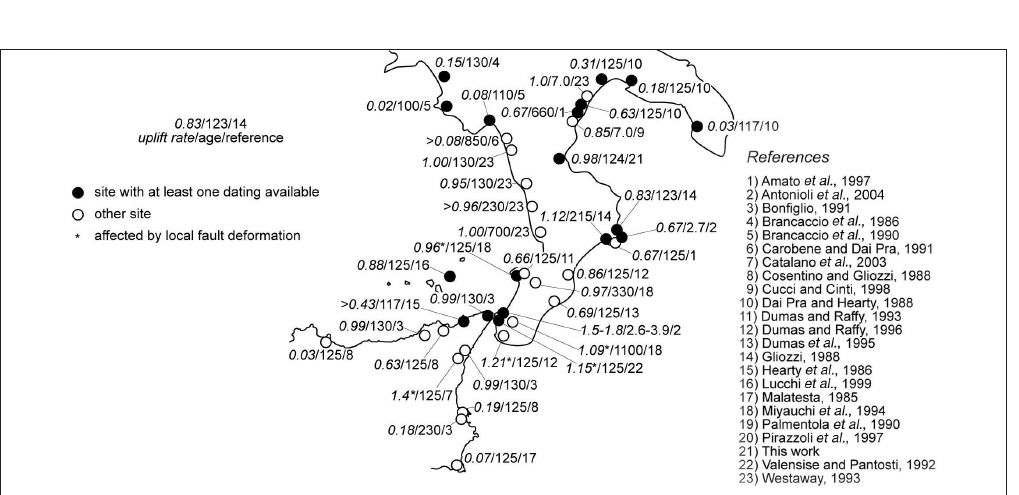
Fig. 10. Summary of Holocene and Pleistocene uplift rates in peninsular Southern Italy and Sicily. Figures shown are mean values (in mm/yr) calculated over the corresponding time (in thousands of years). Solid circles indicates sites where at least one dating (usually AAR or U-Th) was used to assess the uplift; white circles rep- resent other sites where the rates were evaluated through paleontology and/or stratigraphic-geomorphological correlation. For a complete overview of the rates of uplift over the last 125 kyr see Bordoni and Valensise,